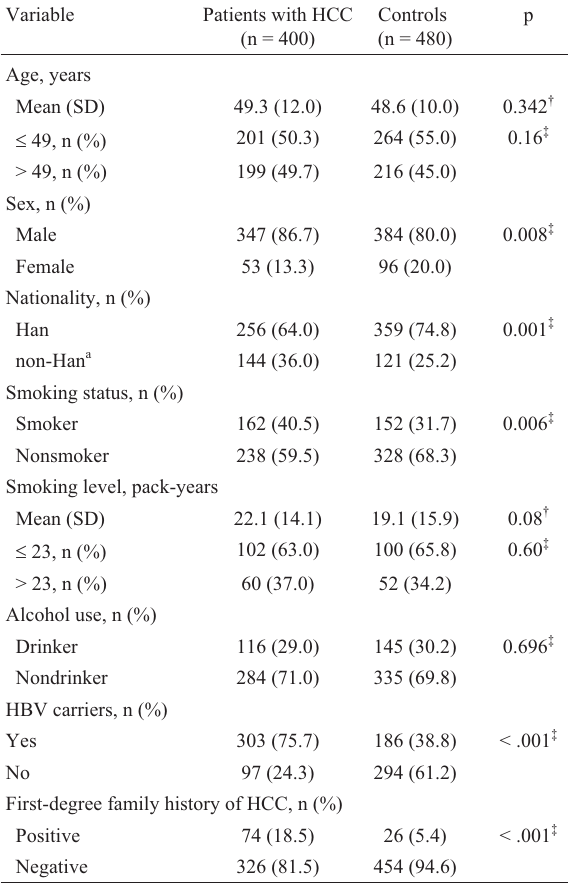
Table 1 - Selected clinical and demographic characteristics of the subjects in the case and control population. Variable Patients with HCC (n =